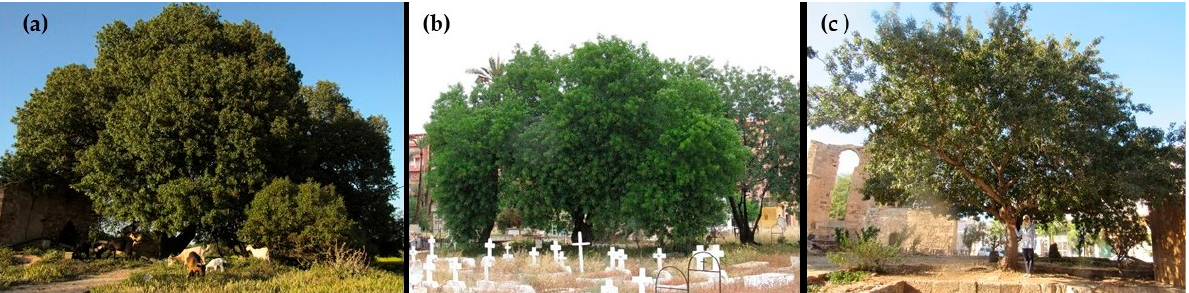
Figure 2. Pistacia atlantica trees in different countries: ( a ), a great P. atlantica tree (female) in the region of Sidi Bel abbes (Algeria), June 2016; ( b ) a vigorous P. atlantica within a dense wild population (here, in an ancient Christian graveyard) in the region of Marrakech, Morocco, March 2018; ( c ) a beautiful P. atlantica (male) in the town centre of Famagusta (Northern Cyprus), October 2017. Personal photos taken by the first author.